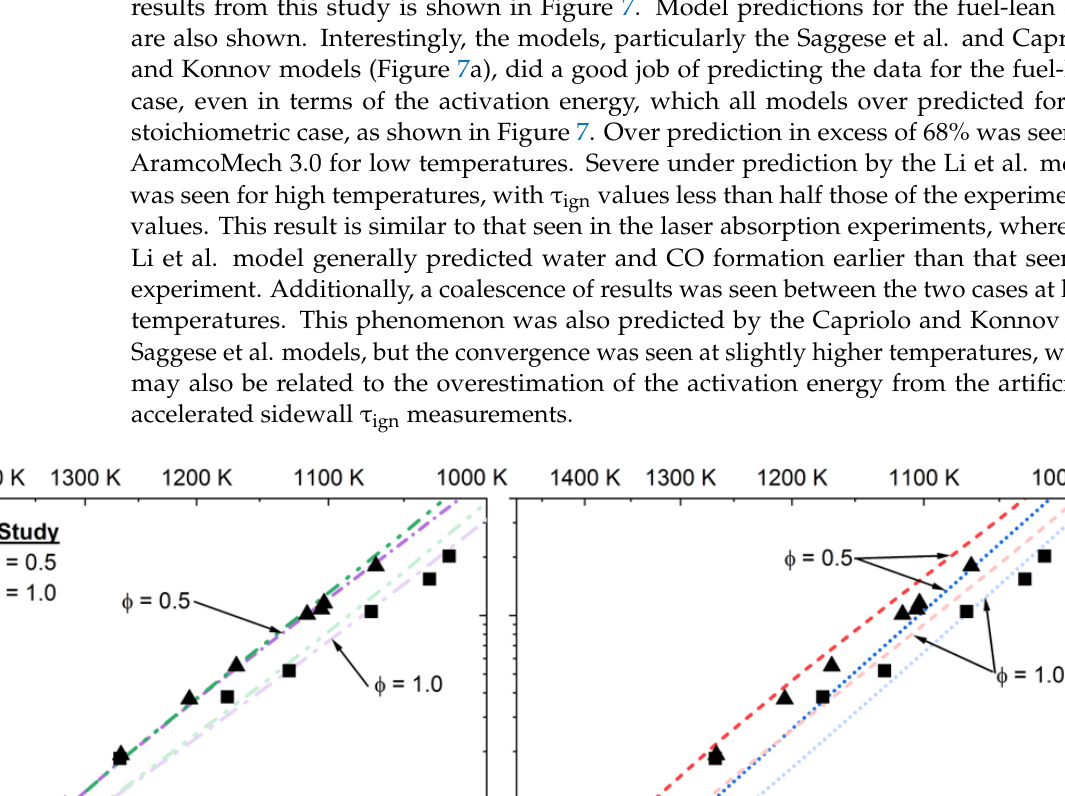
Figure 6. Comparison of stoichiometric, real fuel–air data from this study at 10 atm and those taken by Jouzdani et al. at 12 atm. Predictions made by the four models are also shown.